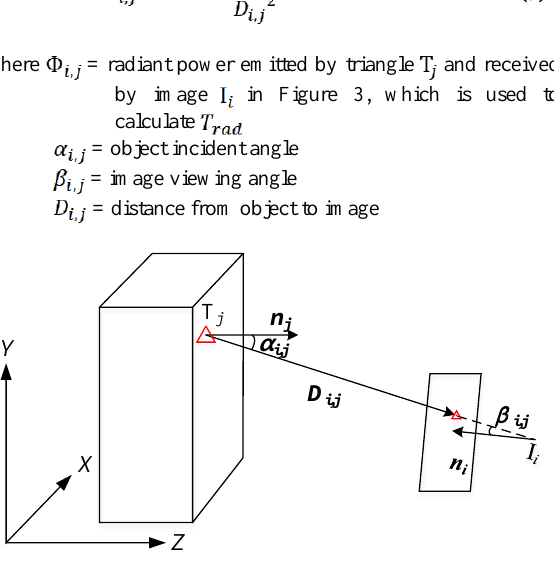
Figure 3. Illustration for thermal radiant characteristics